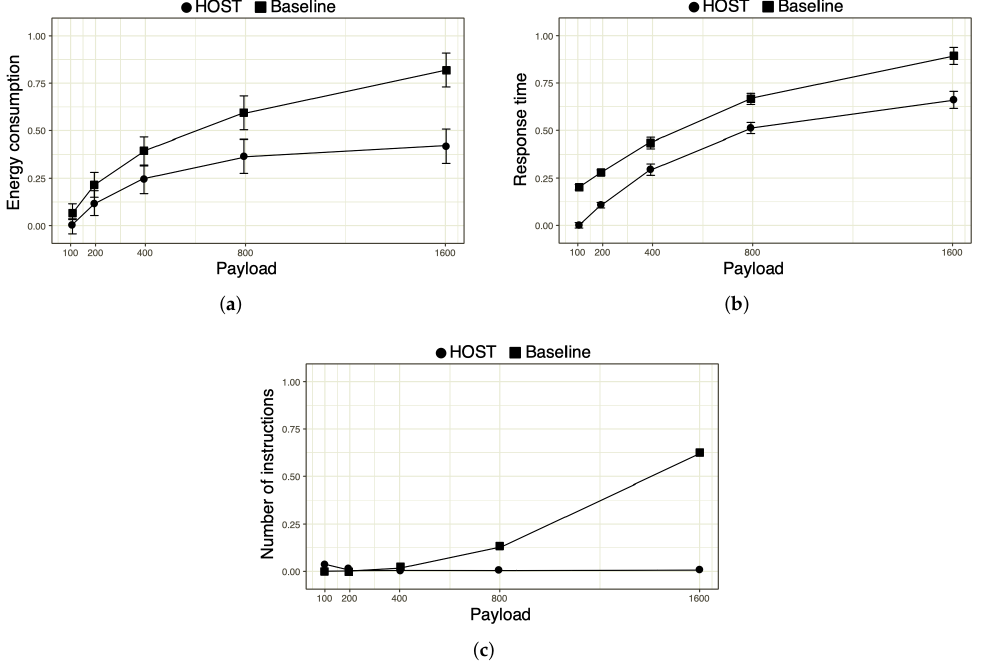
Figure 5. The impact of energy consumption, response time, and the number of instructions. ( a ) En- ergy; ( b ) Response time; ( c )